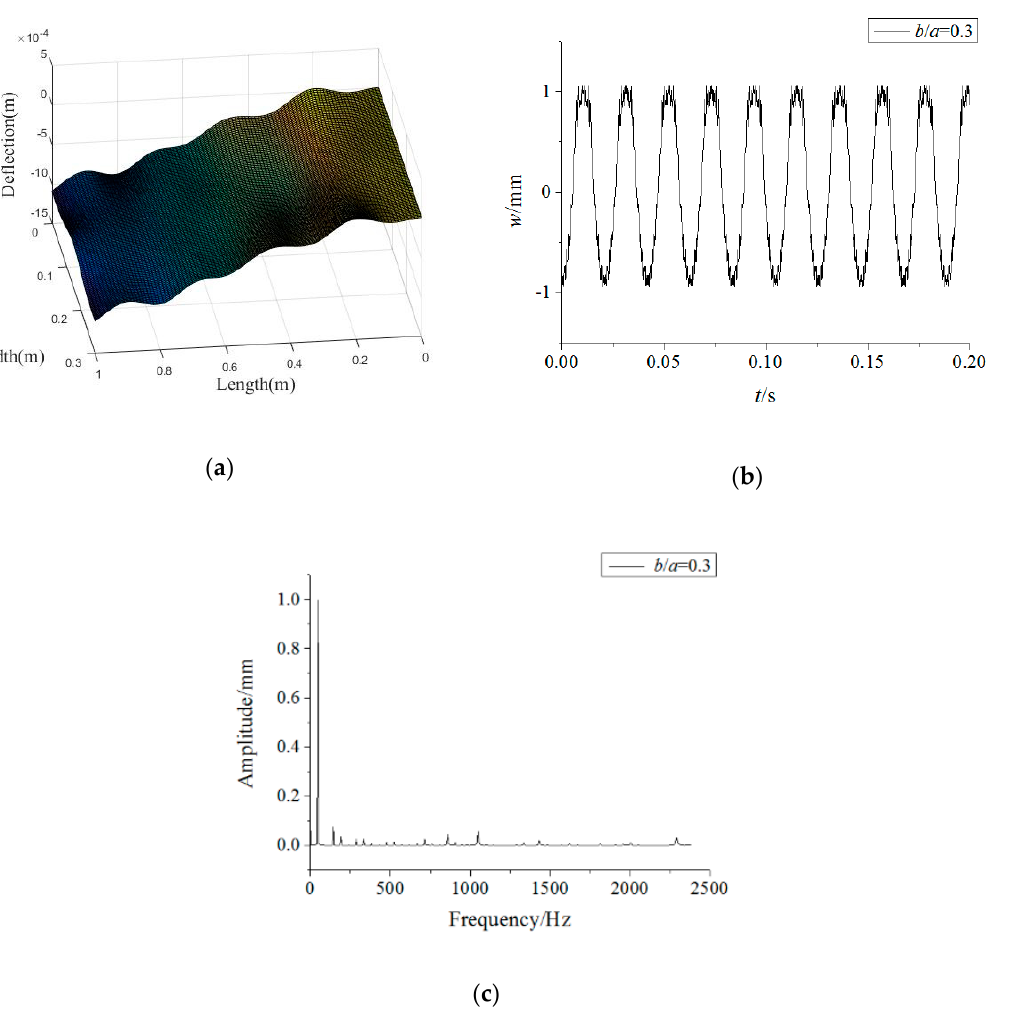
Figure 3. Forced vibration responses of the rotating FGM plate ( a ) vibration mode, ( b ) time-domain response, ( c ) frequency-domain response.